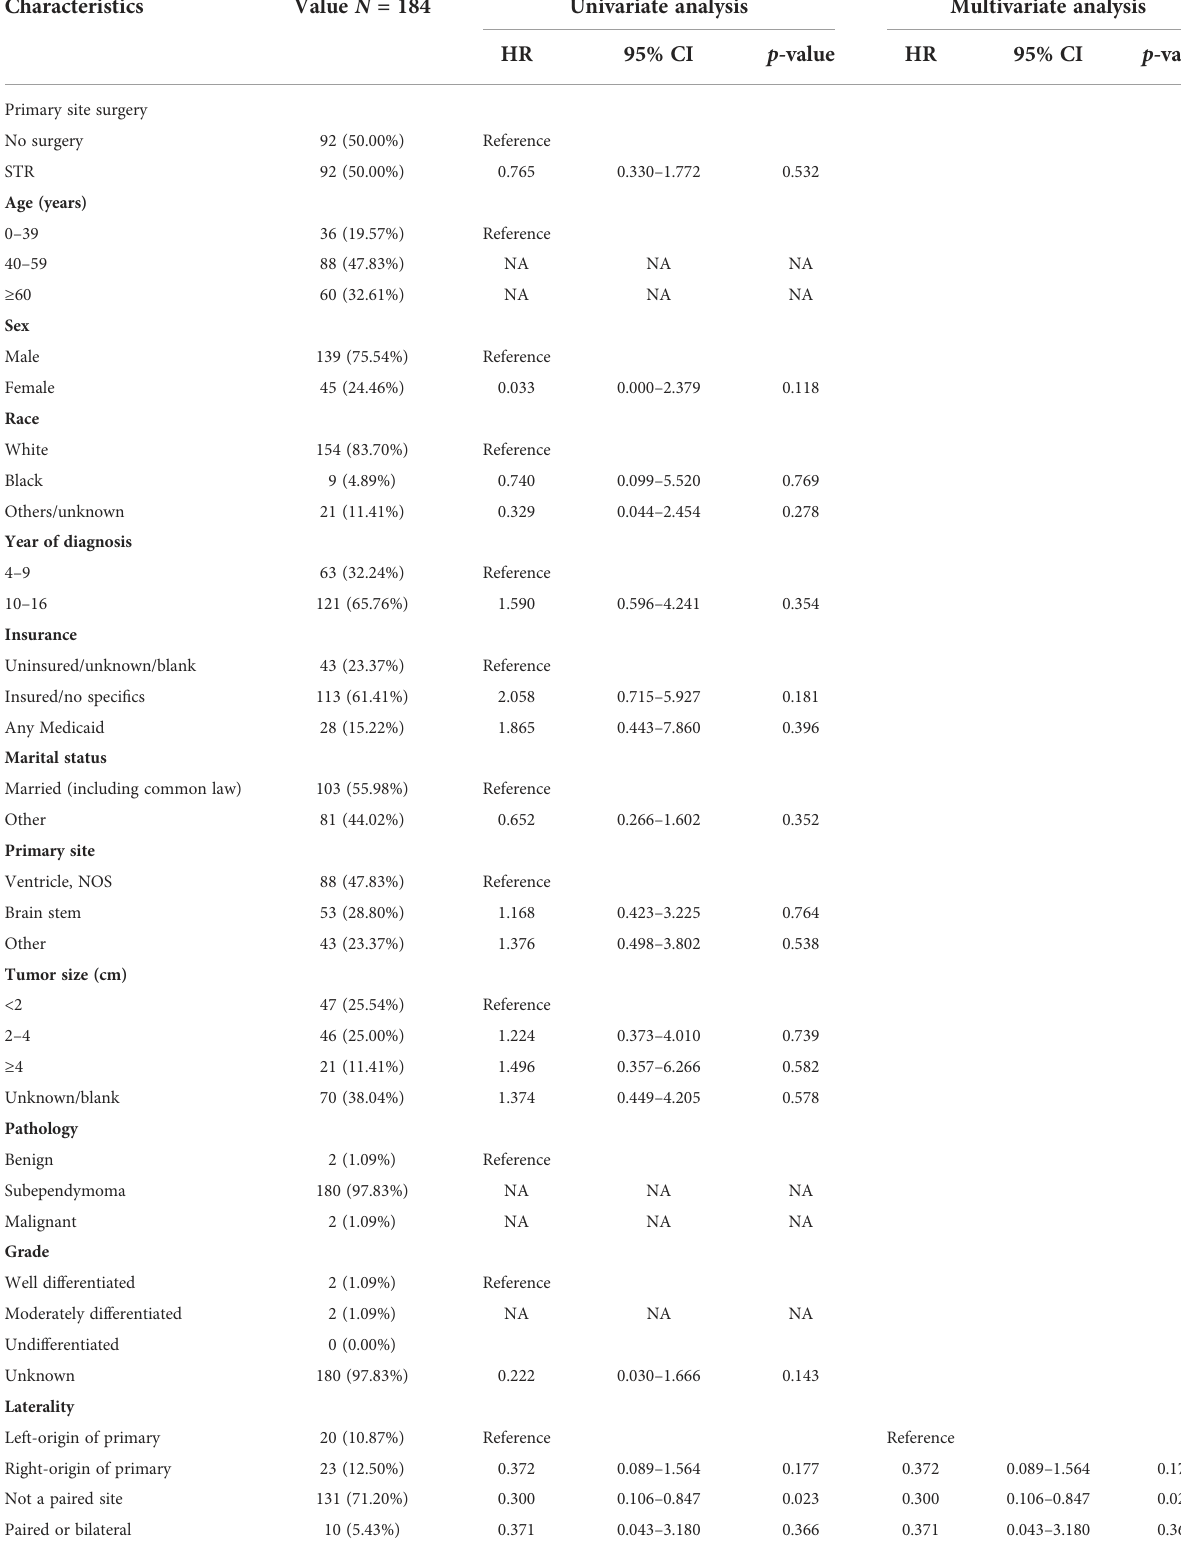
TABLE 5 The characteristics of 184 patients from the 339 patients grouped according to no surgery and STR after